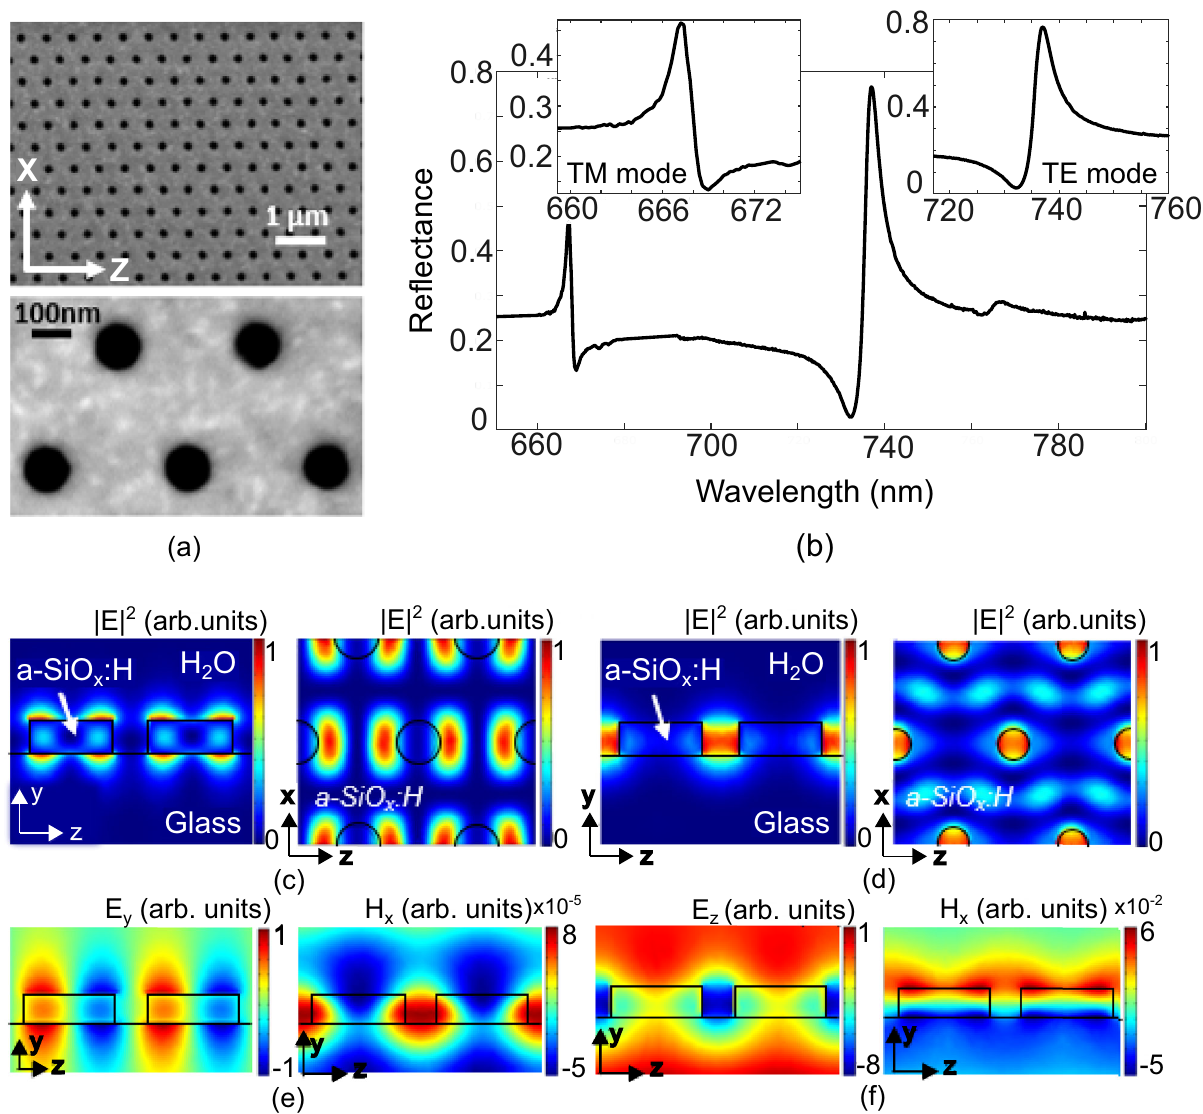
Fig. 1 Con fi guration and results of the dielectric nanohole array. a SEM micrograph of the nanohole array realised in a-SiO x :H in a triangular lattice, showing overview and detail. b Experimental re fl ection spectrum of the nanohole array, highlighting the two main modes. c Cross-section (left) and top view (right) of the energy con fi nement for TM mode and d TE mode at resonance in the nanohole array. Cross-section of e the electric (left) and magnetic (right) fi eld distribution for the TM mode and f the TE mode on